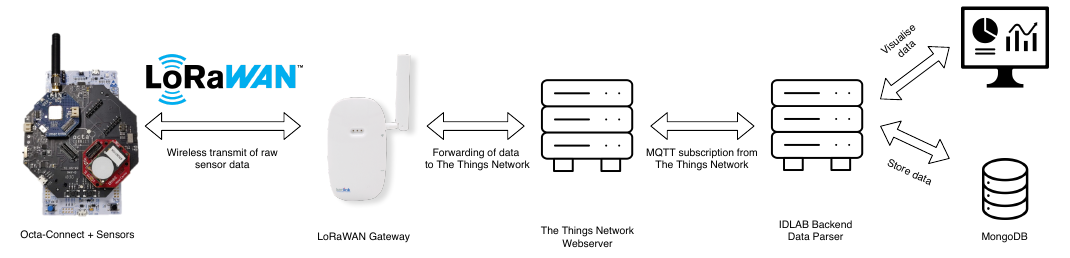
Figure 8. End-to-end data flow from sensors to the dashboard. Table 4. Available sensors